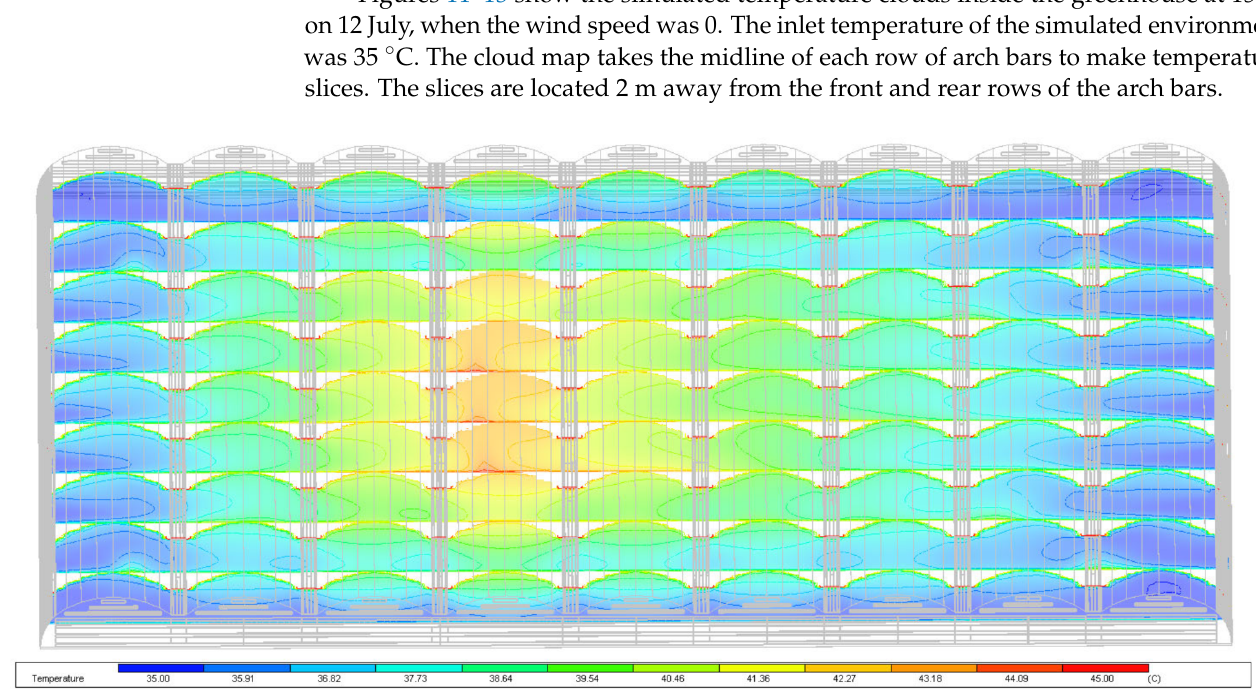
Figure 11. Temperature cloud map of the crossed multi-arch greenhouse (outdoor wind speed 0 m/s, outdoor temperature 35 ◦ C).